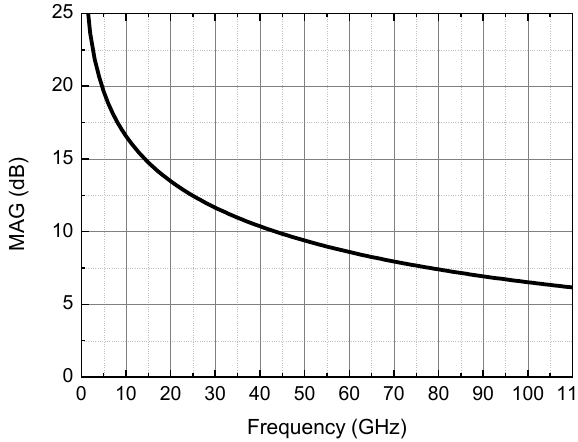
Figure 1. Simulated maximum available gain (MAG) of a 2 × 12 µ m transistor in a bulk 65-nm CMOS technology.